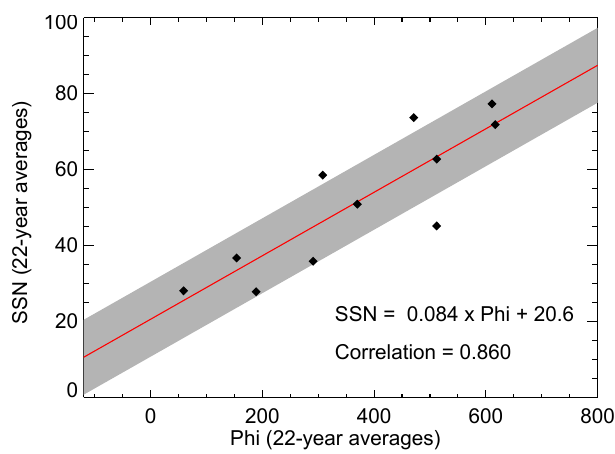
Figure 23. Regression of 22-year averaged SSN to the modulation potential (cid:56) . The grey-shaded area represents the 1 σ uncertainty range of the fit. Regression coefficients and the correlation coef- ficient are also